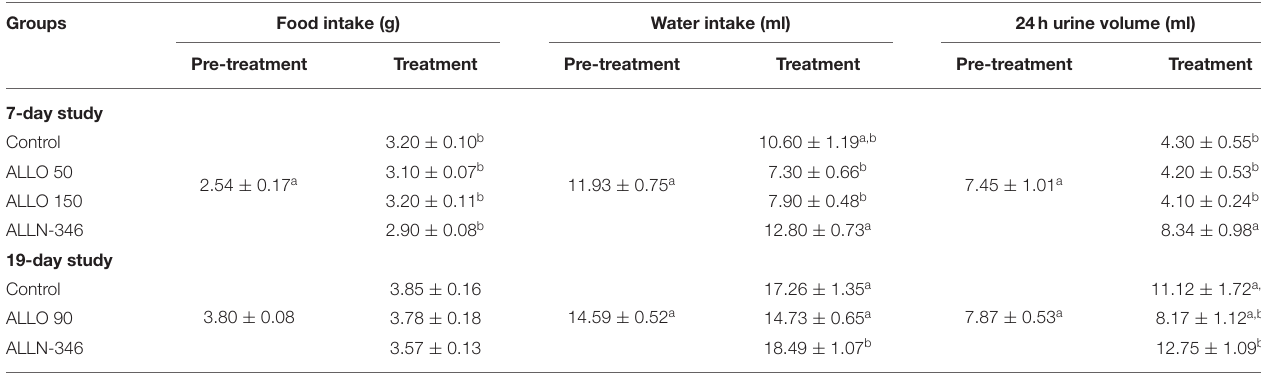
TABLE 1 | Pre- and post-treatment daily food and water intake as well as urine output in uricase/UrOx deficient mice for both the 7- and 19-day studies. Groups Food intake (g) Water intake (ml) 24h urine volume (ml) Pre-treatment Treatment Pre-treatment Treatment Pre-treatment